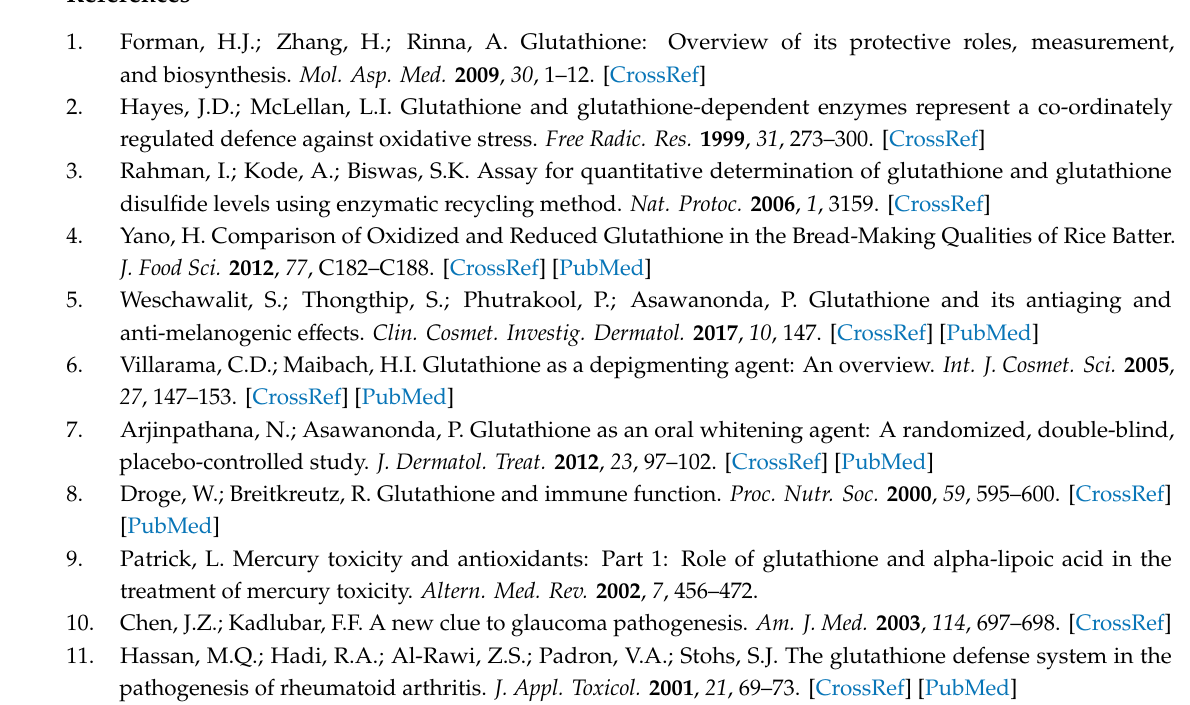
Figure S1: The e ff ect of sodium hyaluronate on odor reduction, Figure S2: GSH 5 -HA MN array